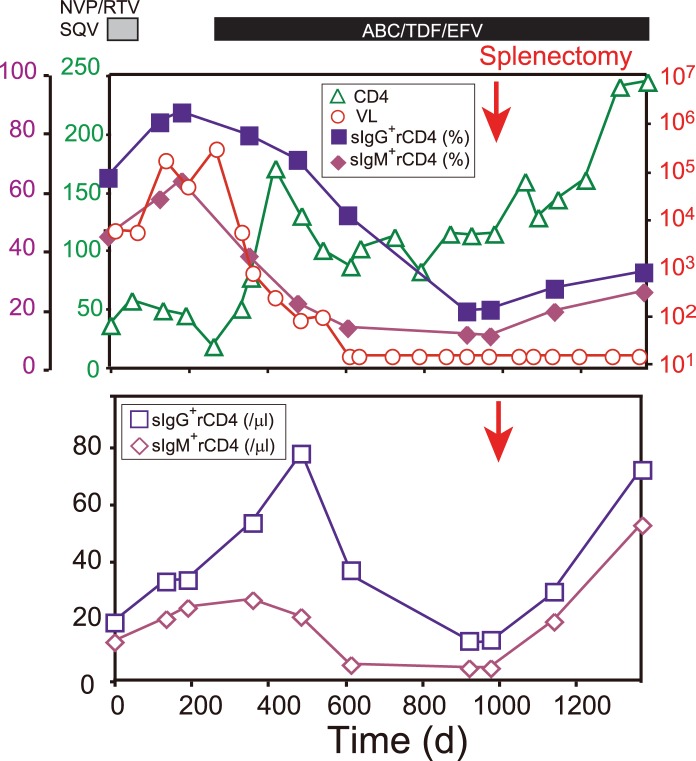
Frequencies and numbers of sIC+ rCD4s in the blood increase after spleen removal.Percentages of sIgG+ and sIgM+ rCD4s in the blood, plasma VL, and CD4 lymphocyte counts (upper), or absolute numbers of sIgG+ and sIgM+ rCD4s (lower) in a hemophiliac HIV-1+ Pt who had undergone splenectomy. Patient interrupted therapy with nevirapine, ritonavir, and saquinavir due to side effects and then initiated therapy with abacavir, tenofovir, and efavirenz. The arrow indicates the day on which the splenectomy was performed.